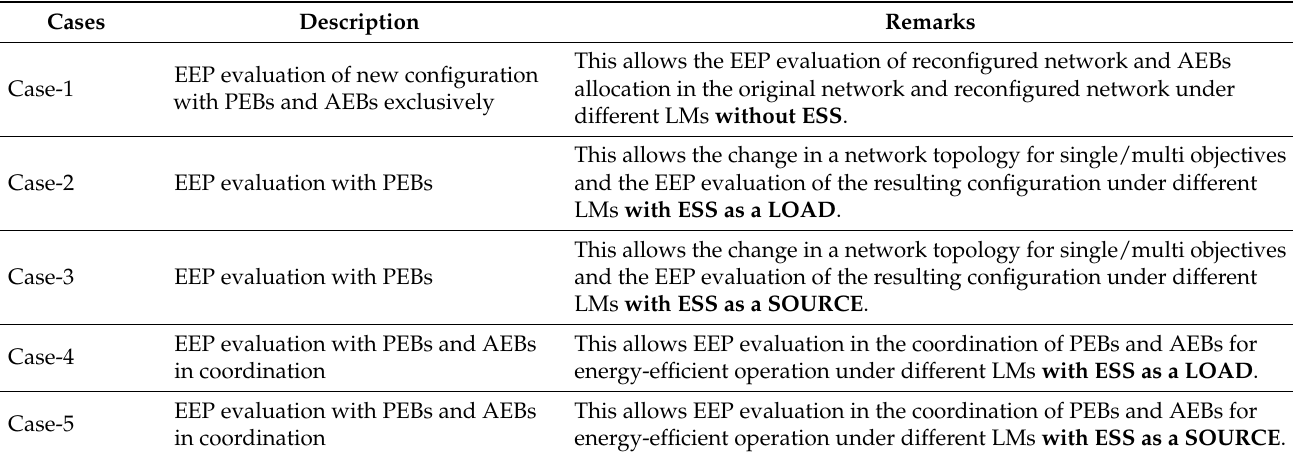
Table 5. The cases of study for EEP evaluation with PLP under different